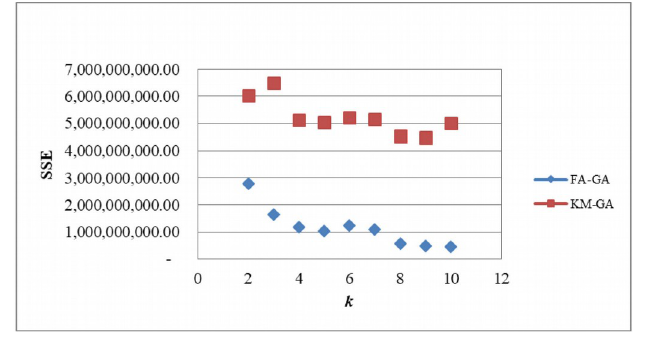
Figure A-2. Sum of the squared error vs. k values for instance P439